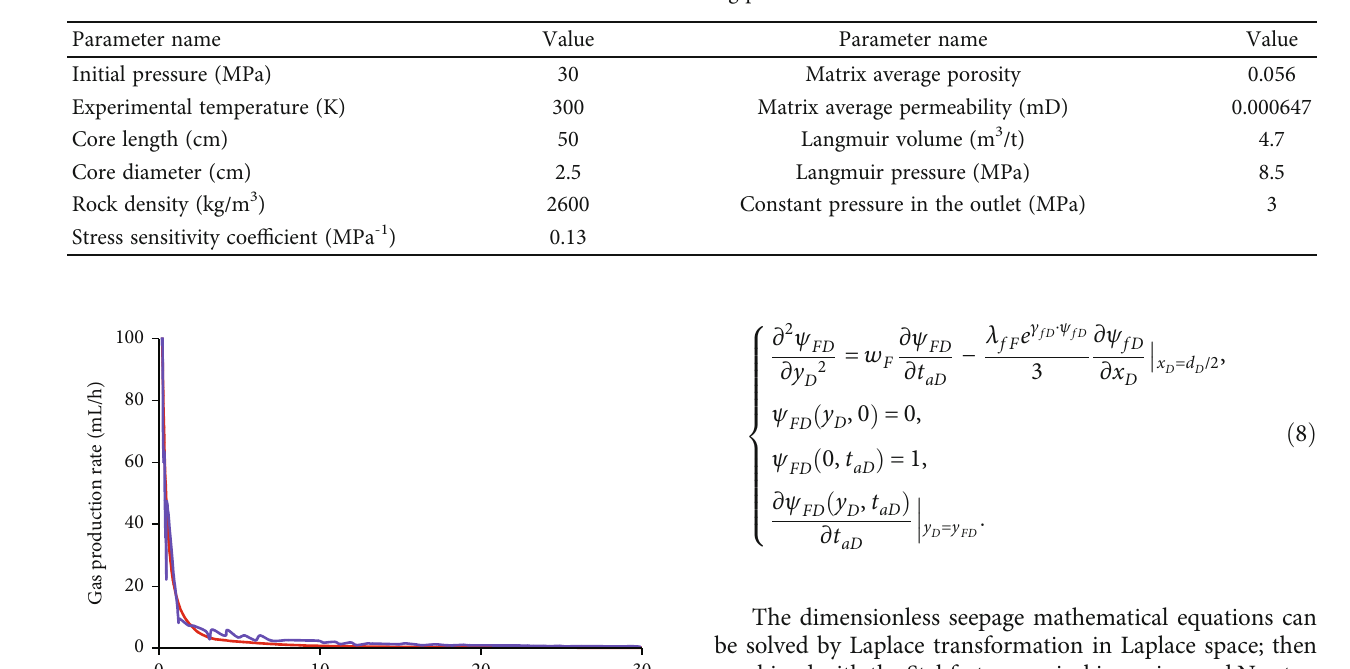
Table 3: Model fi tting parameters.